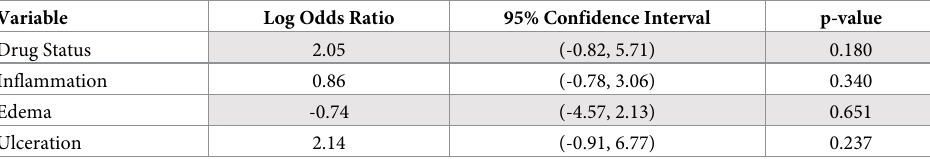
Table 5. Logistic regression model assessing fibroplasia in TNBS mice.